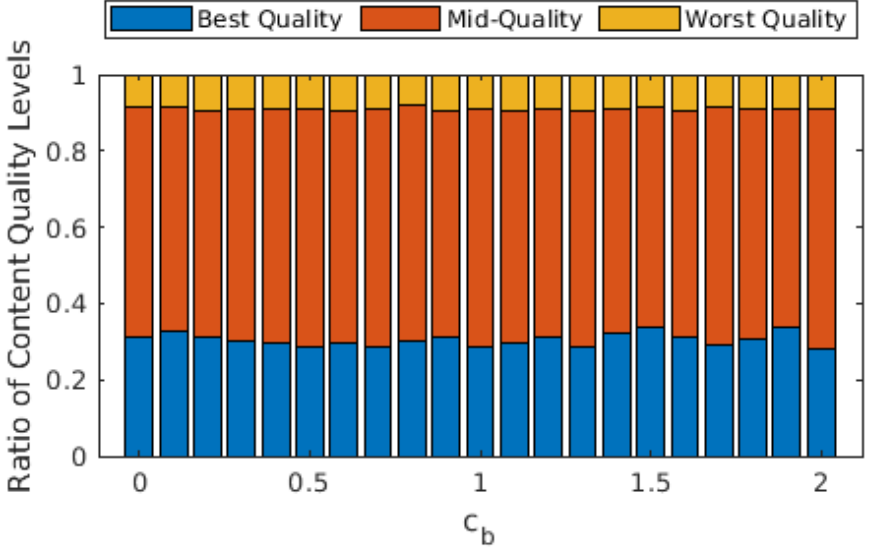
Figure 11. Ratios of the GOPs with respect to quality for different values of c b when transcoding is disallowed. Purple and green lines show the best and (cumulative) mid-quality ratios when D2D mode is